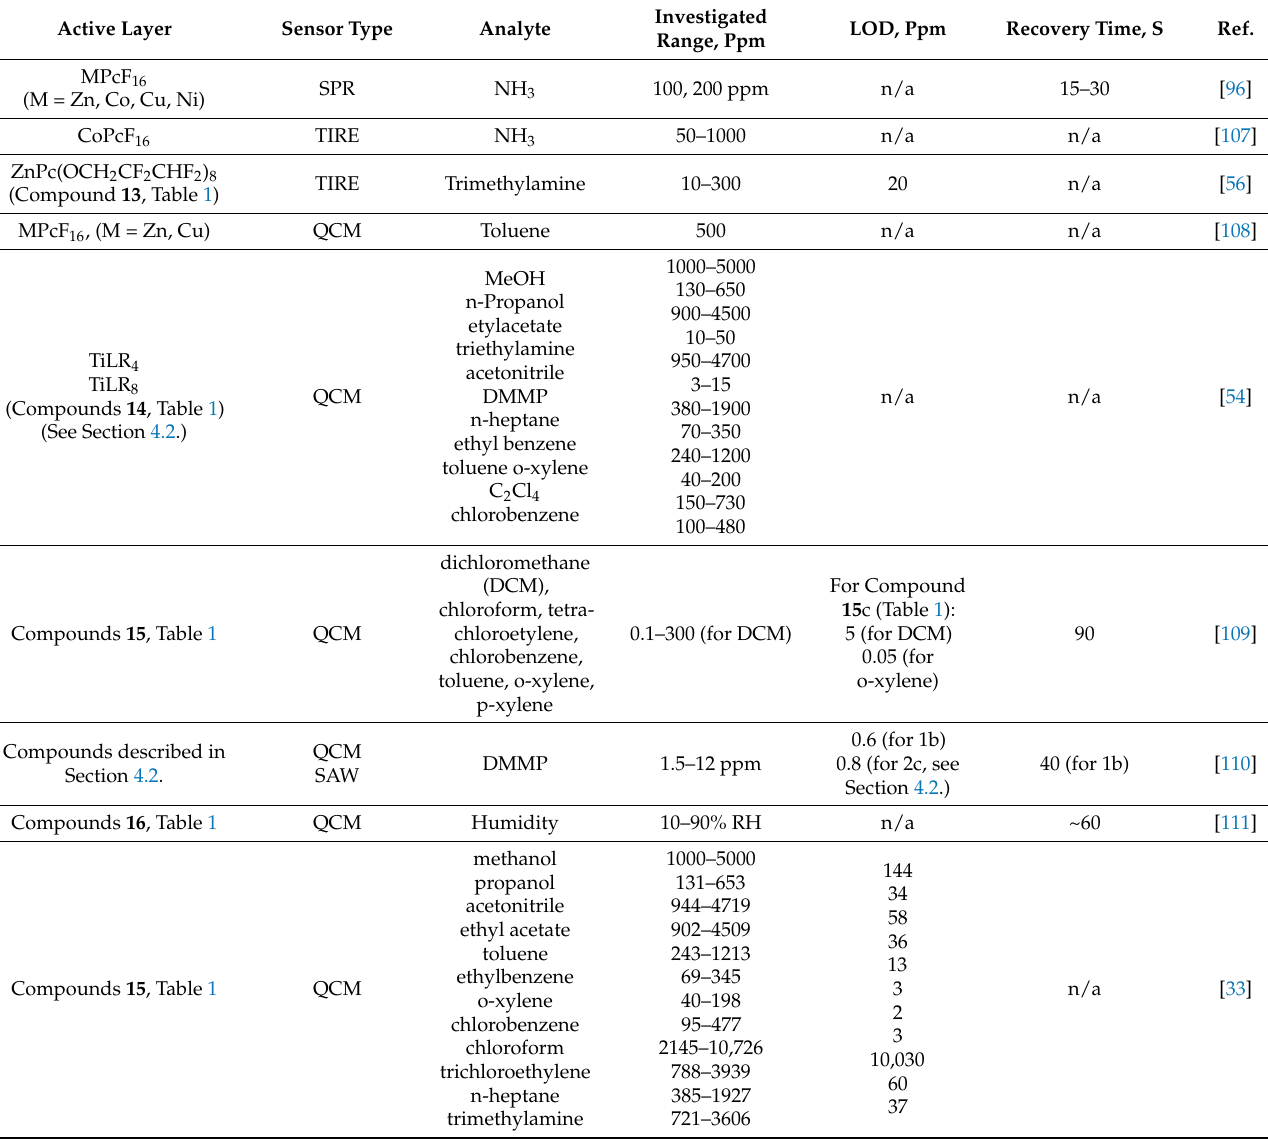
Table 3. Main characteristics of optical and QCM sensors on the basis of fluorinated metal phthalocyanines. Active